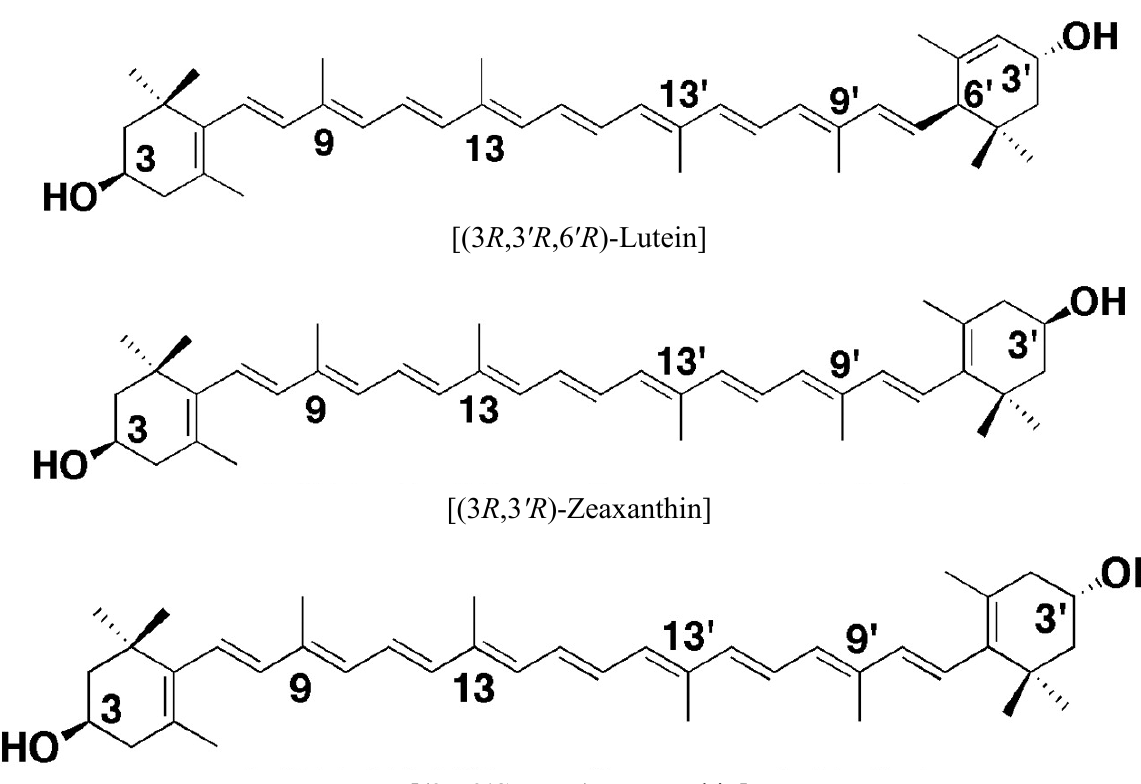
Figure 1. Chemical structures of macula pigments in